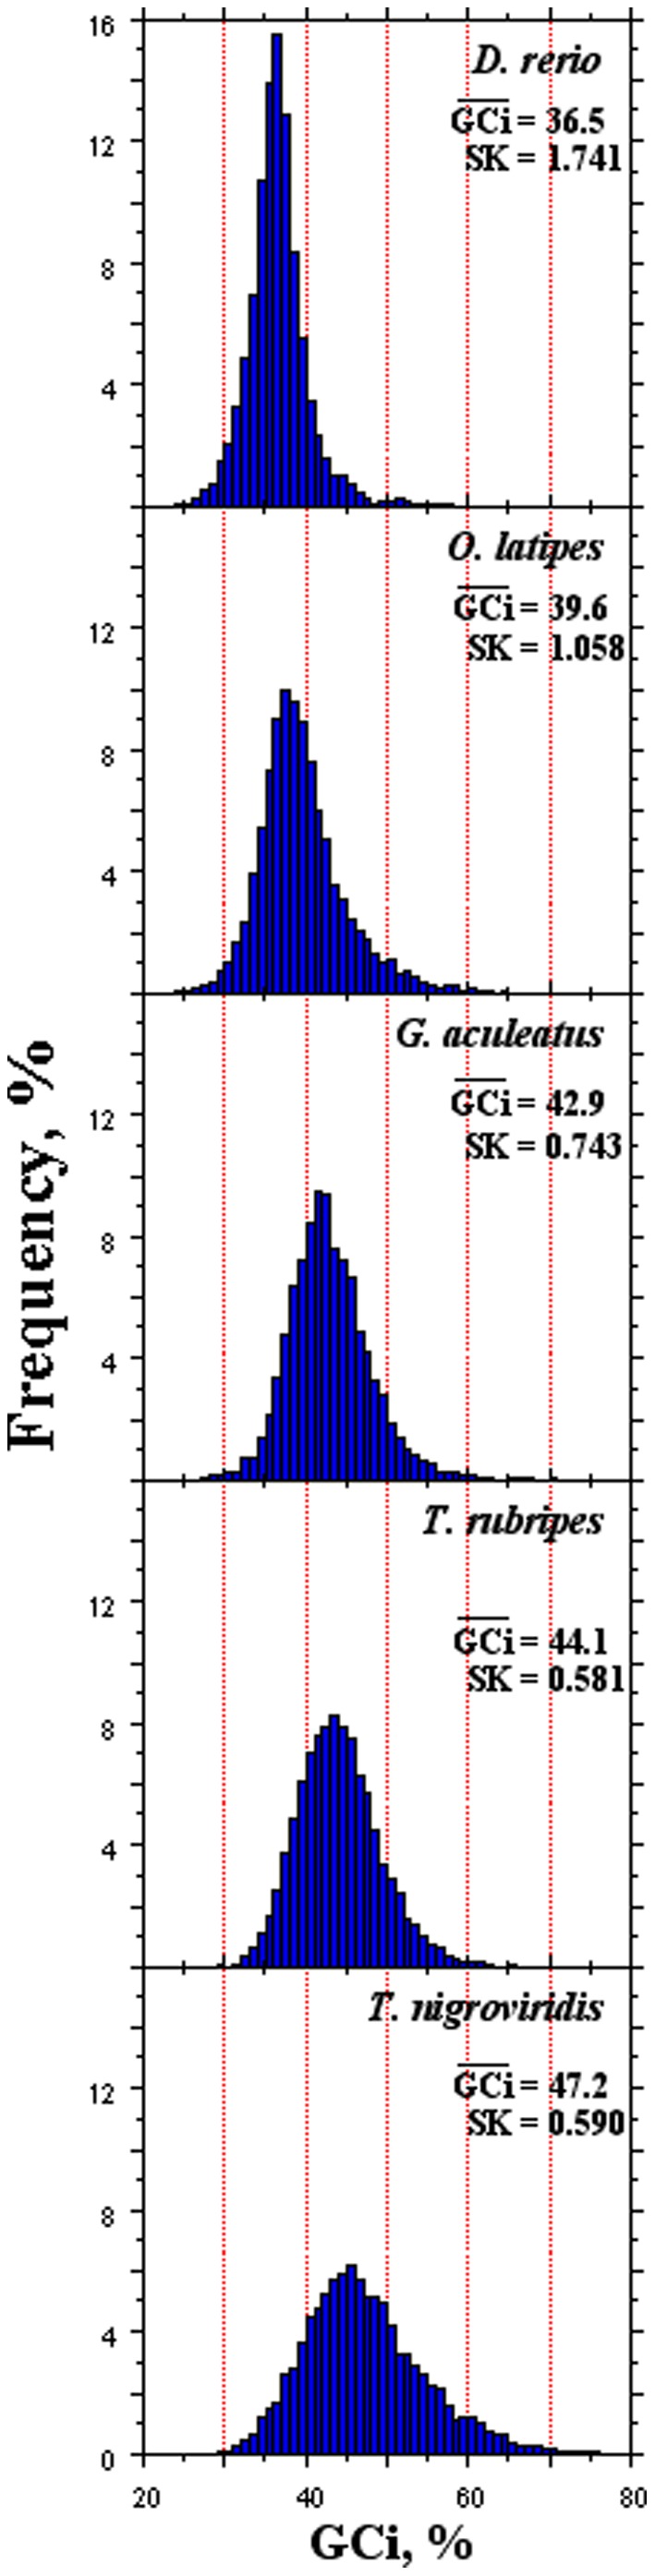
The histograms show the base composition distribution of the intronic sequences (GCi) in the five teleostean genomes.In each panel, the average GCi and the skewness (SK) of the distribution are reported.